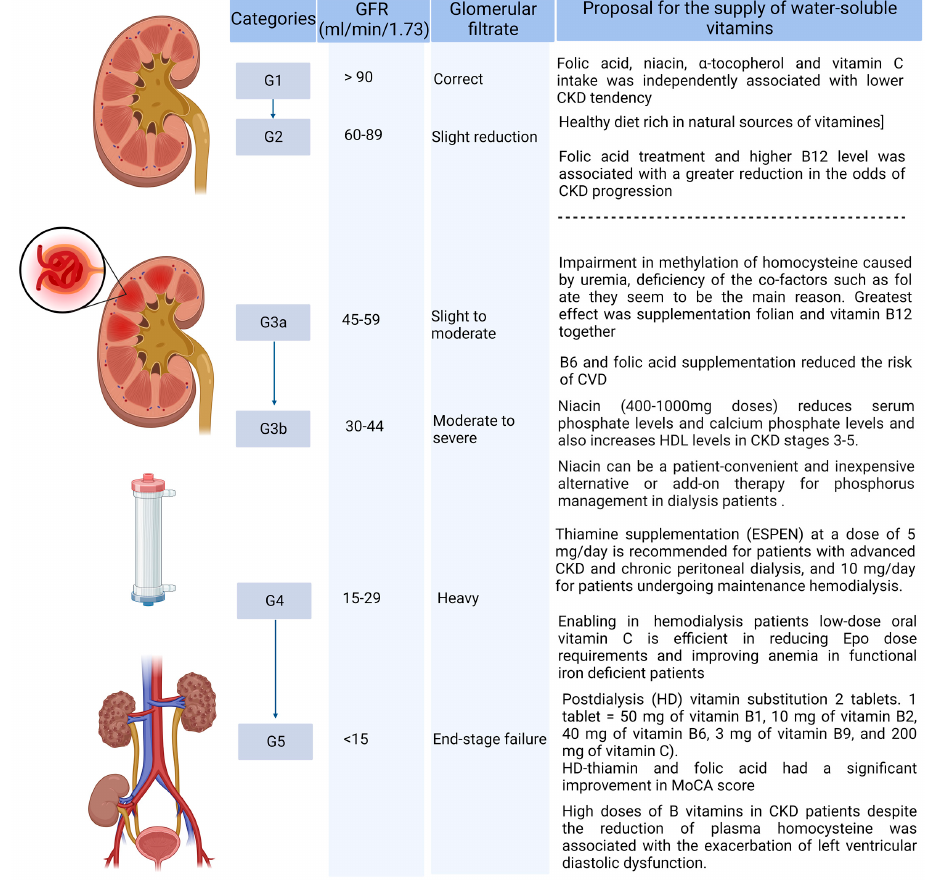
Figure 2. Supply of water-soluble vitamins, taking into account the CKD stage. (Created with BioRender.com https://app.biorender.com/, accessed on 2 February 2023.)